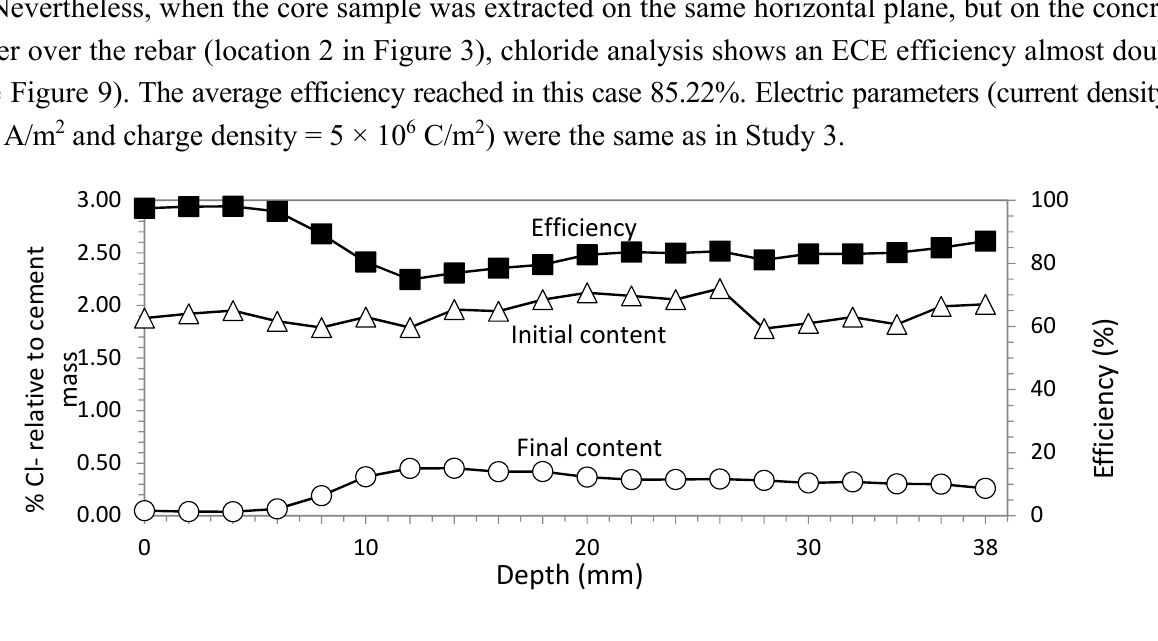
Figure 9. Study 4. Rectangular section specimens. ECE with Ti-RuO 2 mesh anodic system. Variable current density between 3–5 A/m 2 . Current charge density 5 × 10 6 C/m 2 . Contents of Cl − before and after ECE and differences in percentage relative to cement mass, which conform the efficiency profile. Core sample extracted of the concrete cover up to the vertical